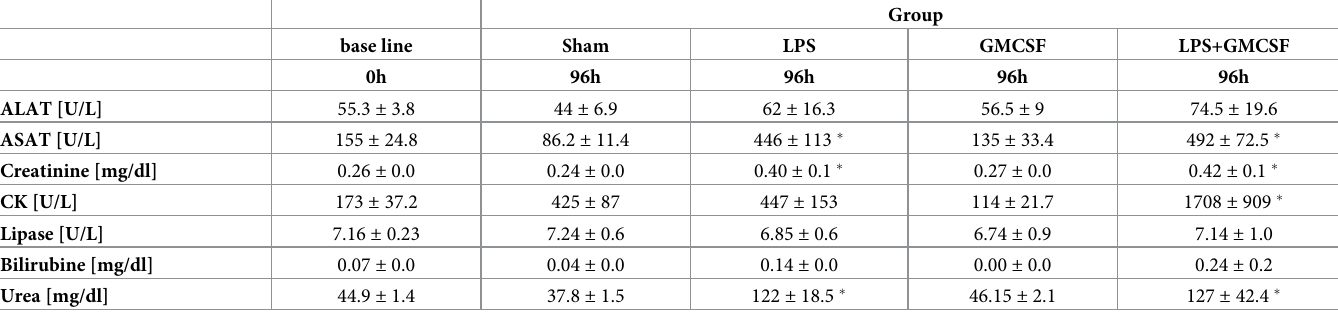
Table 2. Clinically relevant serum parameters.